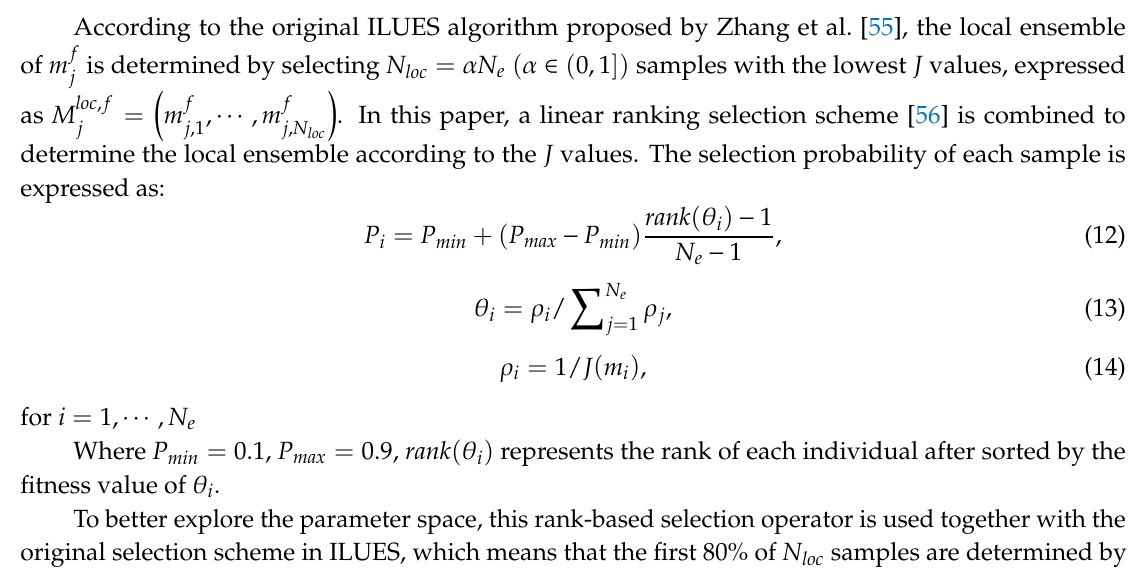
Figure 1. The framework of the iterative local updating ensemble smoother (ILUES) algorithm.